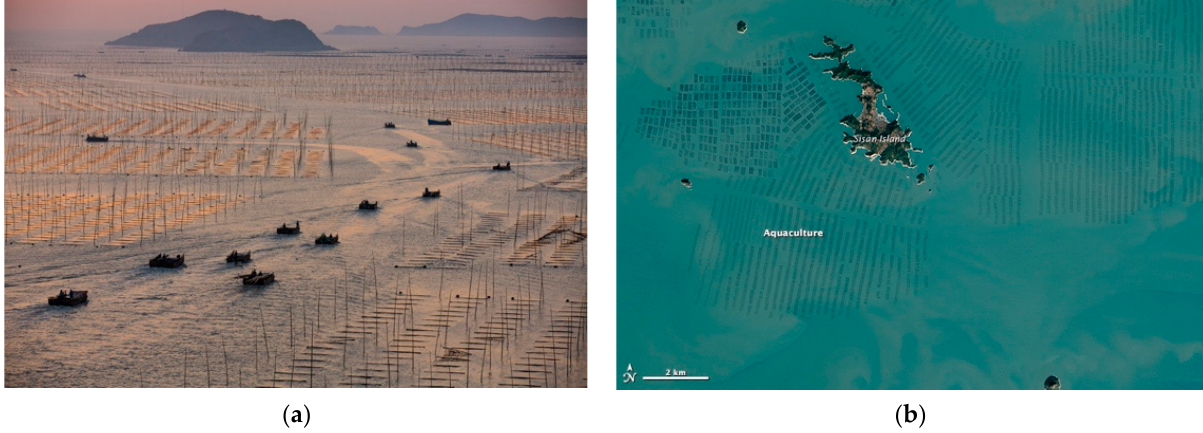
Figure 2. ( a ) Seaweed farmers along the coast in Fujian, China. ( b ) Seaweed and oyster aquaculture on Sisan Island in South Korea.